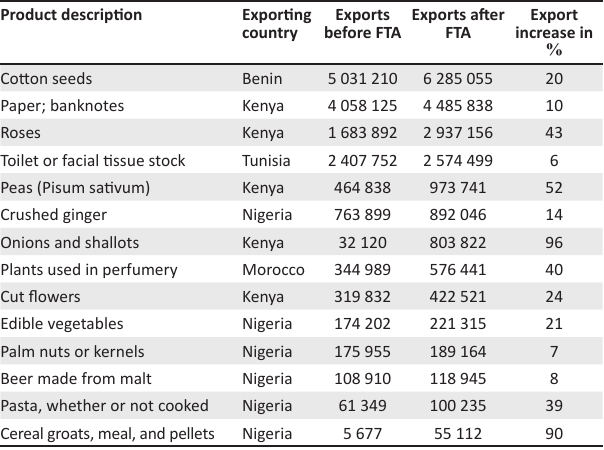
TABLE 6: South African vulnerable products from the Free Trade Area. Product